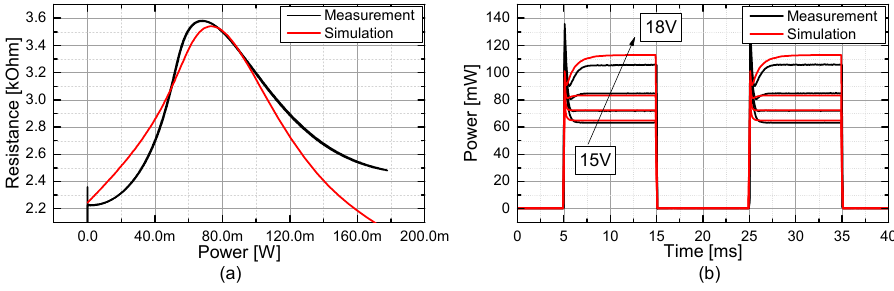
Figure 4. Simulated an measured response for ( a ) constant load and at ( b ) pulsed